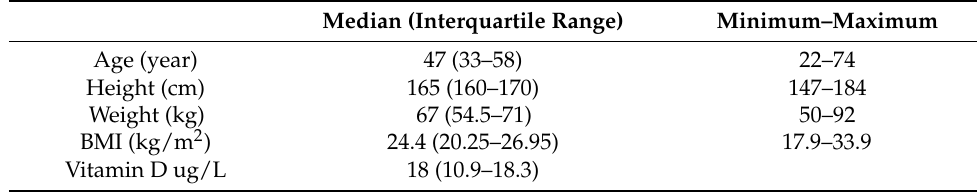
Table 1. Baseline characteristics of subjects.